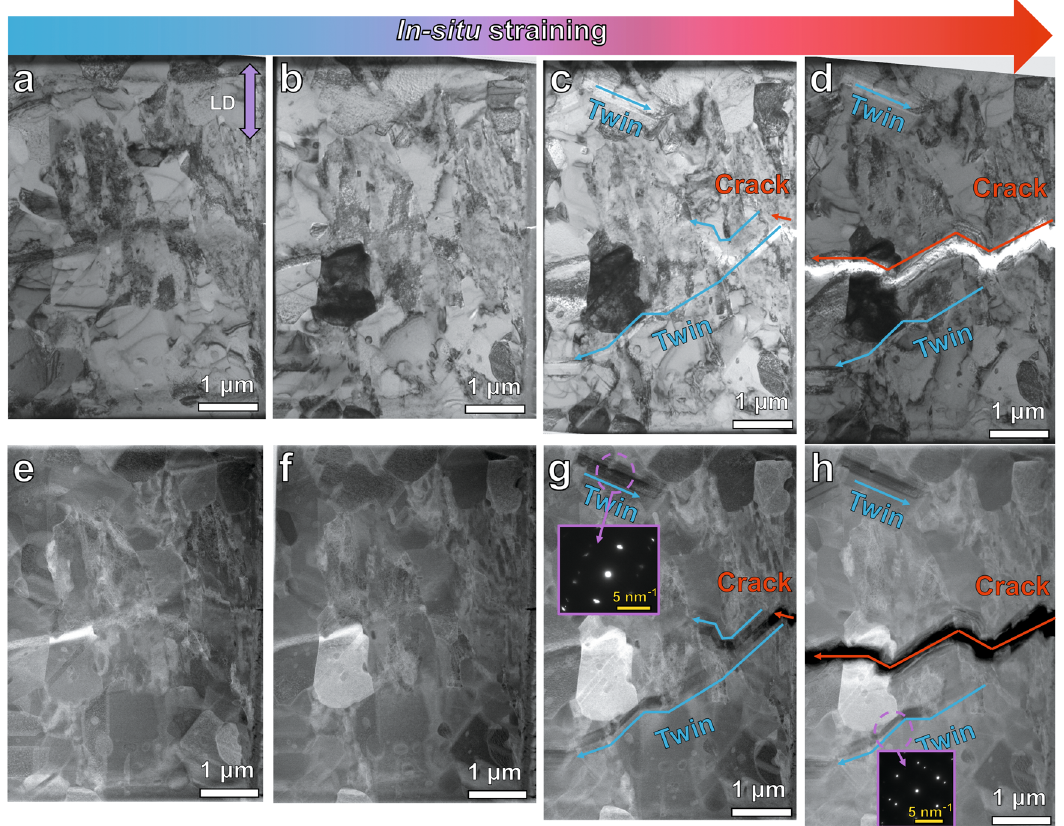
Fig. 3 In situ BF TEM (a – d) and corresponding LAADF STEM (e – h) observations under tensile test for the CCS. a , e Starting microstructure of the CCS prior to tensile loading. b , f Dislocation slip dominates the early stage of deformation. c , g Formation of mechanical twins at various regions when a crack nucleates. d , h Cracks propagate into different grains, while fracture at the interfaces among B2 and the austenite matrix is suppressed. The inserted SAED patterns in g and h reveal twinning structures, and the correspondingly indexed pattern is shown in Supplementary Fig. 4. LD indicates the loading direction.